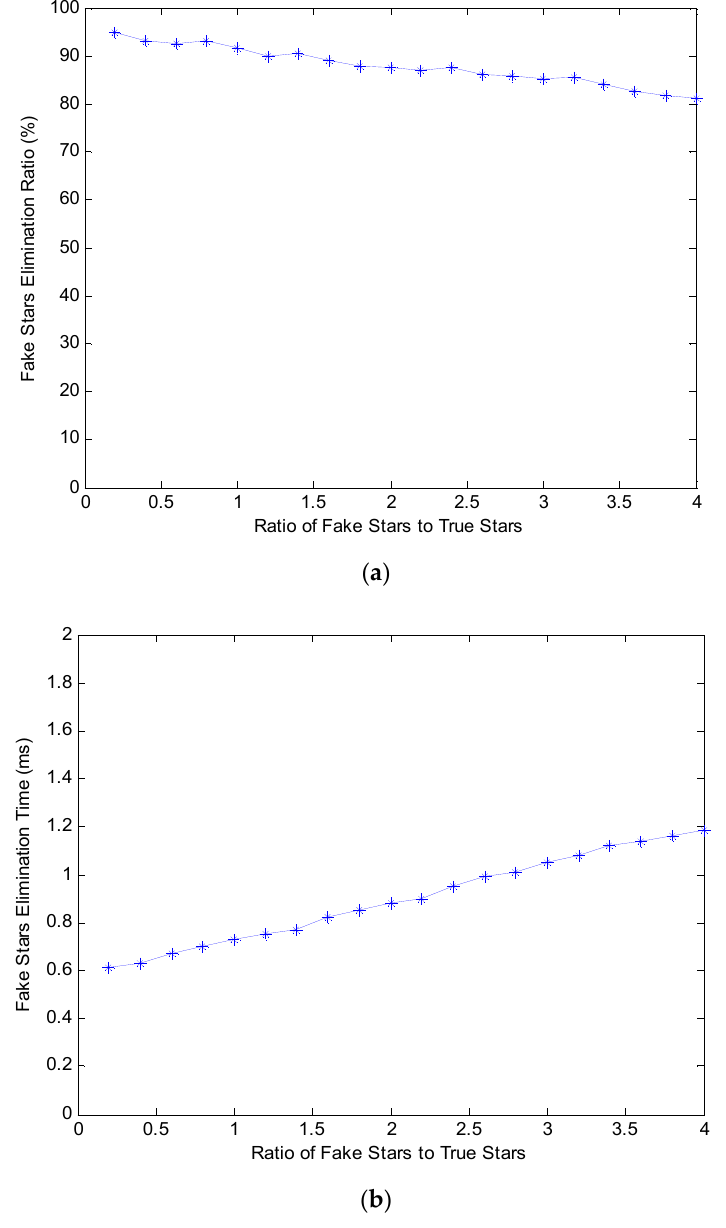
Figure 7. ( a ) Elimination ratio; ( b ) Elimination time.